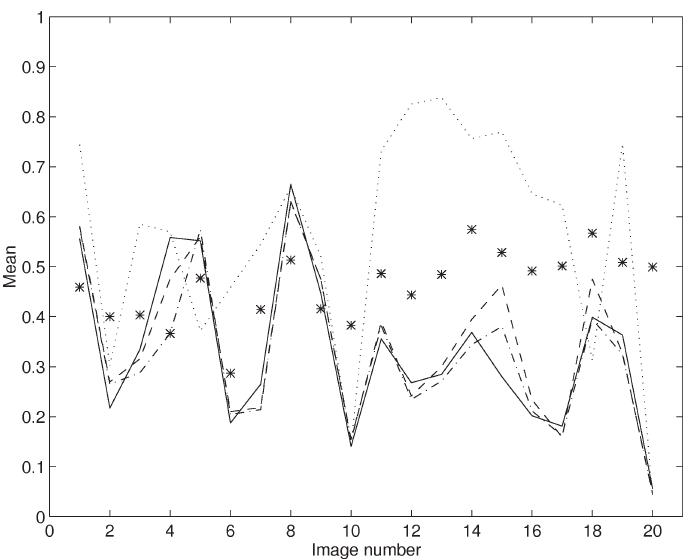
Fig. 8. Mean values for the four different ML methods and the proposed method on 20 tested fields of view, where 1–10 are stained using DAB and 11–20 are stained using Ni-DAB. Line: training image variation means; dashed line: intraoperator variation means; dash–dot line: intraoperator and training image variation means; dotted line: classification image variation means; asterisks: means for proposed